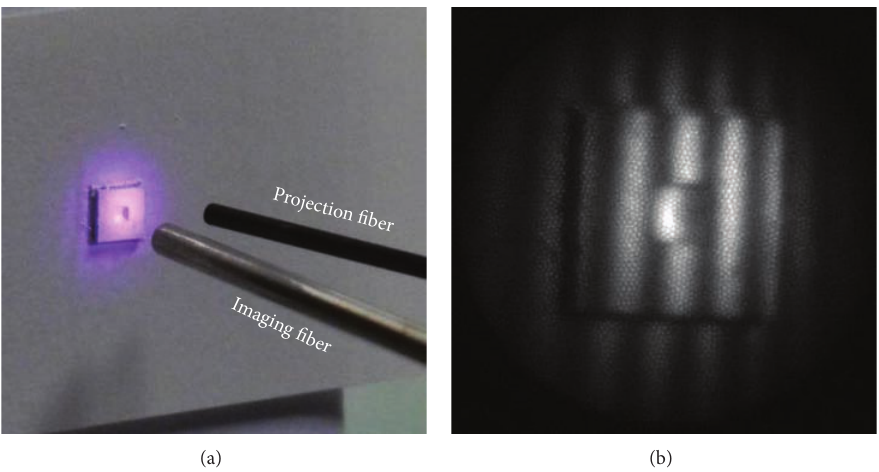
Figure 7: Open-space scenario. (a) Closeup of the fiber distal end. (b) A fringe pattern recorded by the camera.